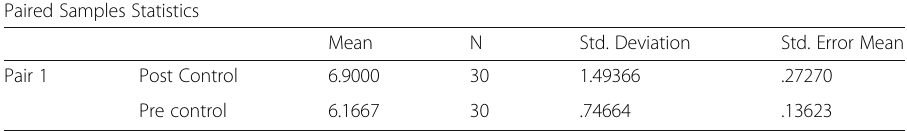
Table 9 Descriptive statistics of the Control Group: Non-DA-based Paired Samples Statistics